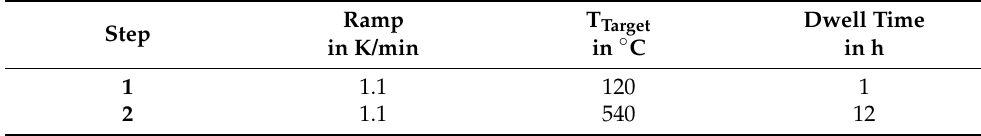
Table 2. Standard calcination procedure in air of catalysts after impregnation.